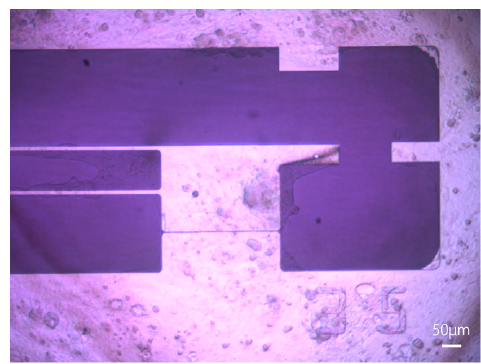
Figure 4. Micrograph of hiPSC-CMs immediately after attachment to a movable plate. After the hiPSC-CMs were cultured for several days, they began to beat. This photograph shows hiPSC-CMs 6 days after